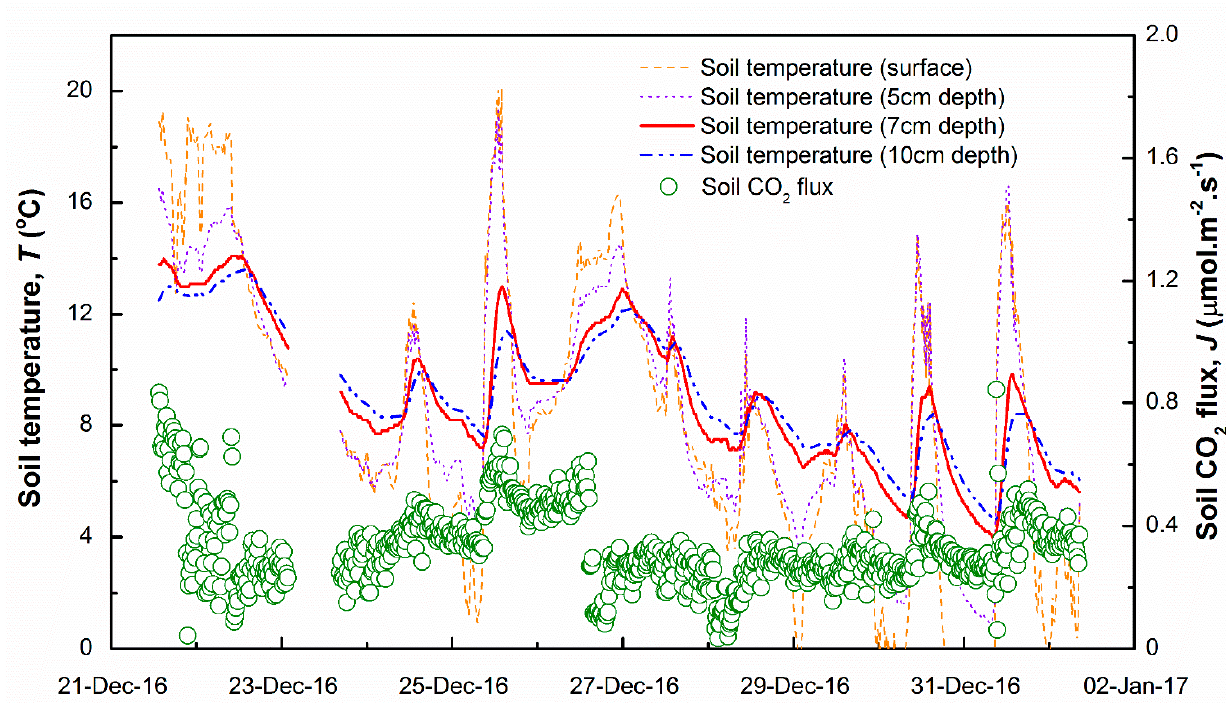
Figure 8. Soil temperature on the surface and at three different depths, recorded at Location A (Dec 21, 2016 to Jan 2, 2017).